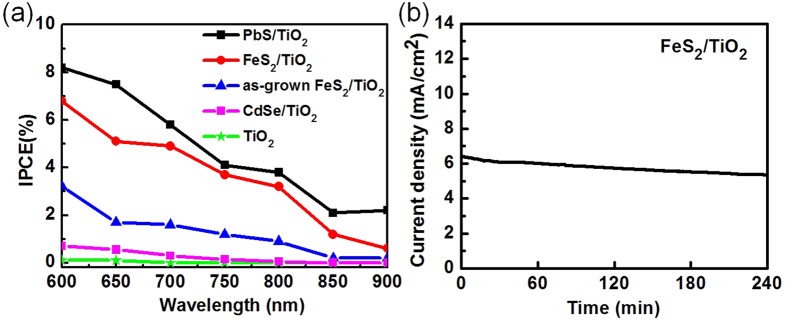
(a) Incident photon to current conversion efficiency of TiO2, CdSe/TiO2, as-grown FeS2/TiO2, FeS2/TiO2 and PbS/TiO2 photoanodes. (b) Stability test of the FeS2/TiO2 photoanode in the alkaline electrolyte (pH = 13.5) with SO32−/S2O32− as sacrificial agent under NIR laser (808 nm) illumination (300 mW/cm2).